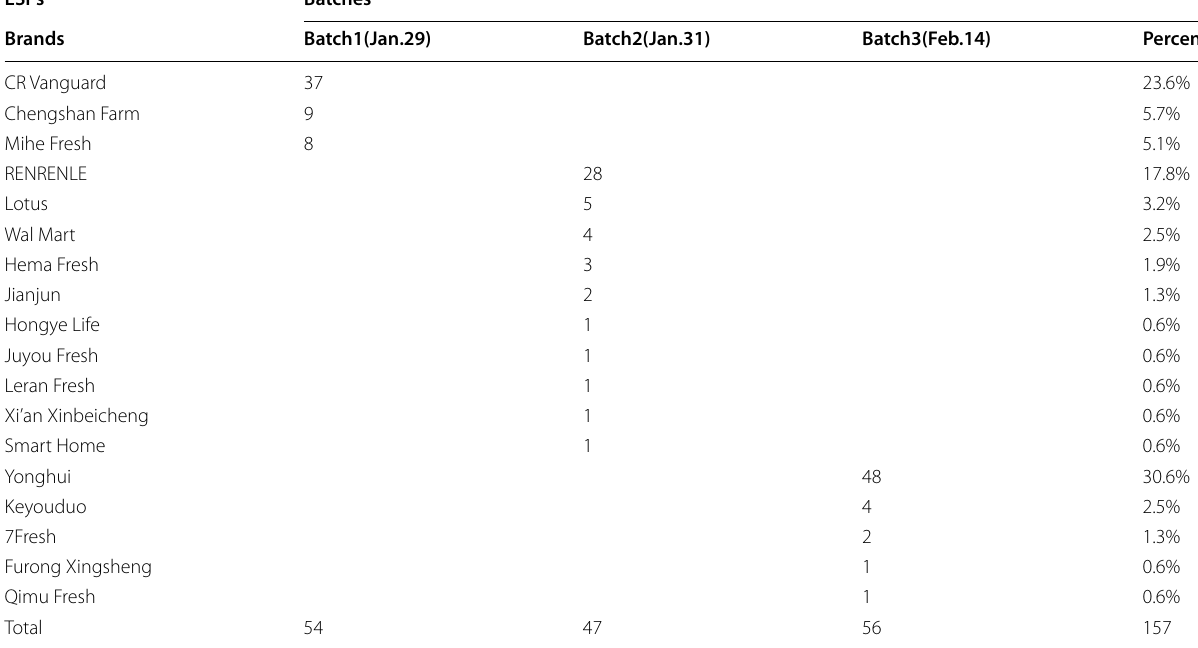
Table 1 Brands and quantity of different batches of